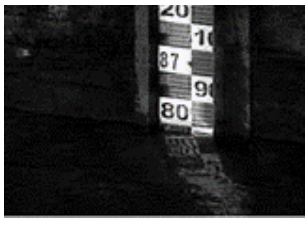
Figure 3. Image enhancement.